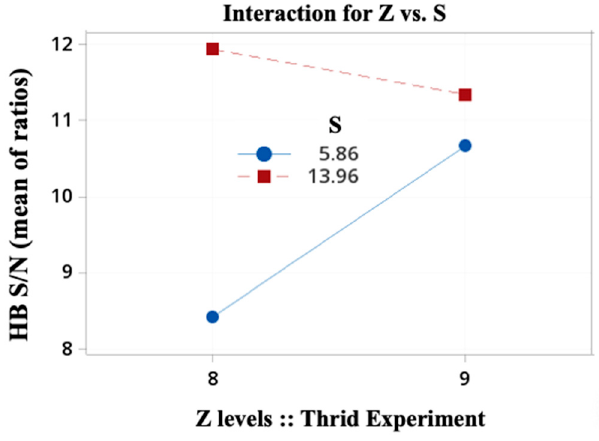
Figure 14. Interaction plot between Z and S for the second Taguchi experiment (see Table 5).